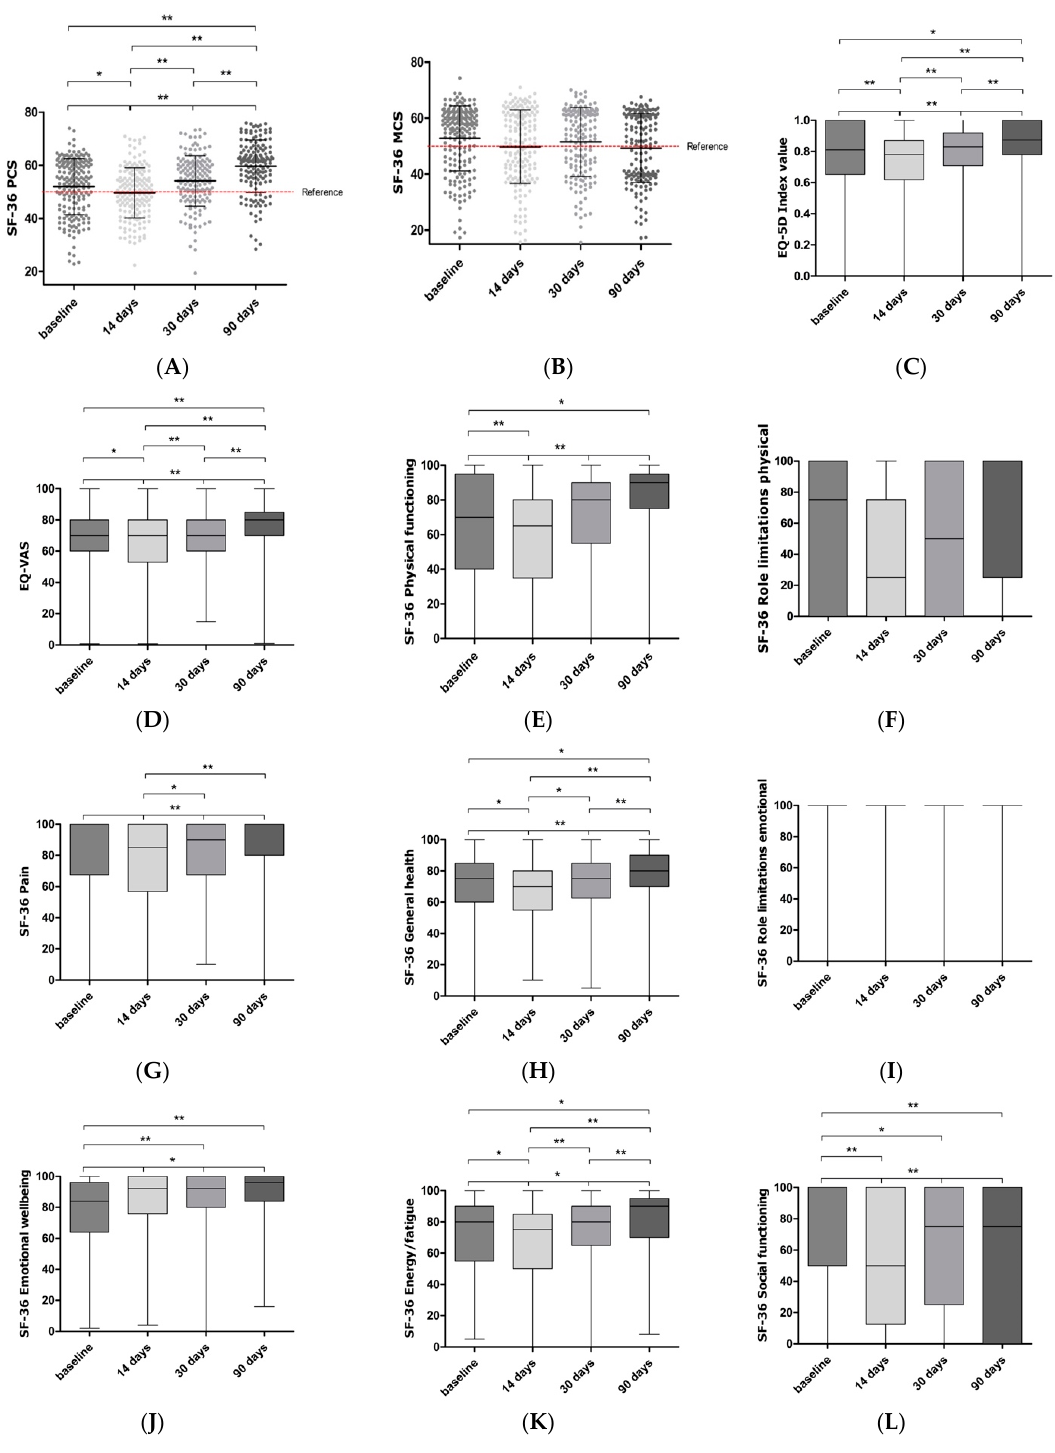
Figure 2. Different domains of the Short Form 36 (SF-36) and Euro Quality of Life (EQ-5D) questionnaires after totally endoscopic cardiac surgery. A physical component score (PCS; ( A )) and metal component score (MCS; ( B )) was calculated from the different domains of the SF-36. These included physical functioning ( E ), role limitations physical ( F ), pain ( G ), general health ( H ), role limitations emotional ( I ), emotional wellbeing ( J ), energy/fatigue ( K ) and social functioning ( L ). The EQ-5D is represented through the index value ( C ) and the Visual Analogue Scale (VAS; ( D )). Data are shown as median and interquartile ranges. The reference line represents the mean of a reference population (ischemic heart disease in Belgium). Significance is indicated as * p < 0.05; ** p < 0.001.